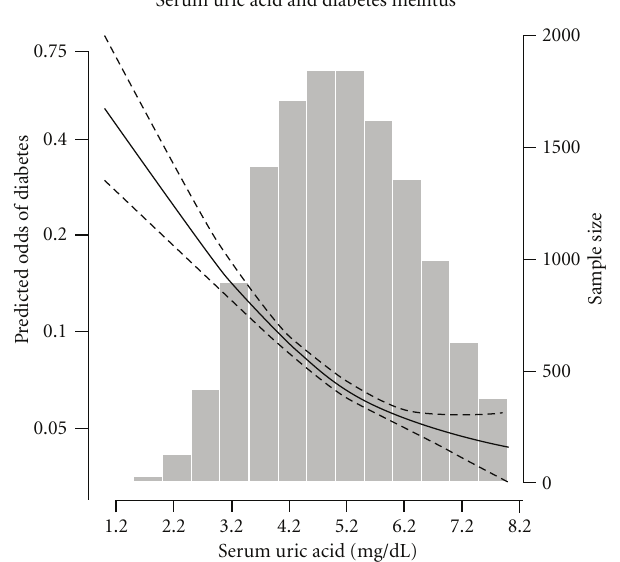
Figure 1: Multivariable-adjusted odds of diabetes mellitus accord- ing to serum uric acid level. Solid thick line represents the predicted odds of diabetes estimated from nonparametric logistic regression employing the generalized addictive-modeling approach (R system for statistical computing, Comprehensive R Archive Network (http://www.CRAN.R-project.org/)); dashed lines, 95% confidence limits for the nonparametric logistic regression estimates. The nonparametric logistic regression was adjusted for age (years), sex (men, women), race-ethnicity (non-Hispanic whites, non- Hispanic blacks, Mexican Americans, etc.), education categories ( < high school, high school, > high school), smoking (never, former, current), alcohol intake (never, former, current), BMI (normal, overweight, obese), and serum total cholesterol (mg/dL). x axis: serum uric acid level (mg/dL) plotted in log scale, y 1 axis: predicted odds of diabetes mellitus plotted in log scale, and y 2 axis: participant number for each serum uric acid